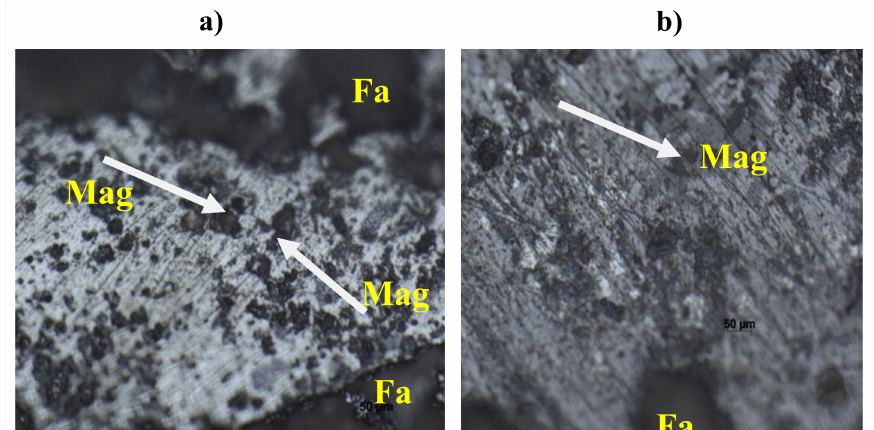
Figure 14. ( a ) Microscopic image of the conventionally sintered preform at 20X and ( b ) microscopic image of microwave sintered preform at